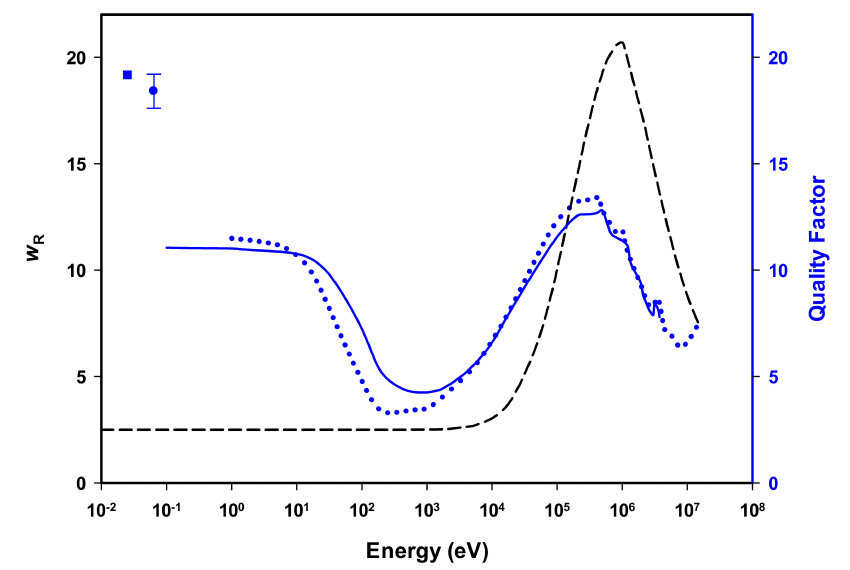
Figure 1. Illustration showing comparison of ICRP neutron radiation weighting factor w R (black dashed line) [10], and smoothed quality factor distributions calculated by Cross and Ing (blue dotted line) [13] and by Stinchcomb and Borak (blue solid line) [14], and thermal neutron quality factors calculated by Schuhmacher and Seibert (blue square) [11] and Ali et al. (blue circle)